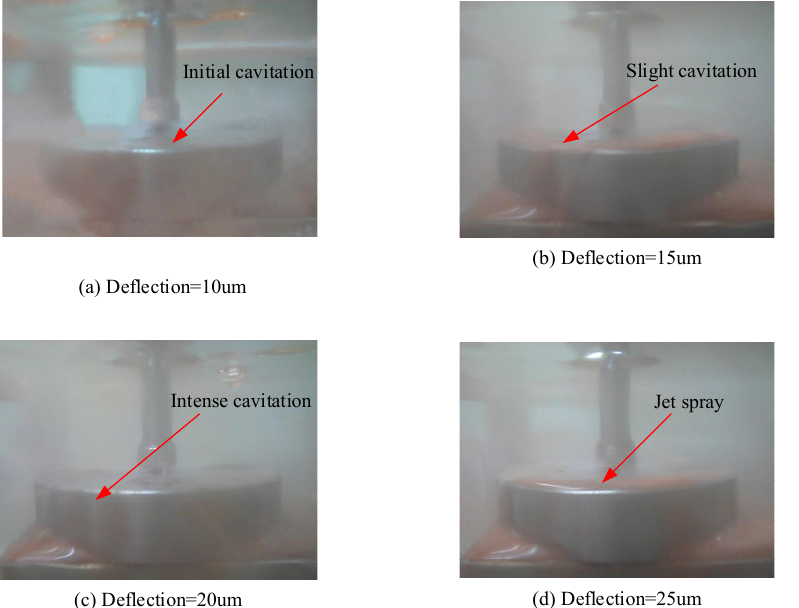
Figure 24. Cavitation phenomena with different deflection. ( a ) Cavitation phenomenon with the deflection of 10 μ m; ( b ) Cavitation phenomenon with the deflection of 15 μ m; ( c ) Cavitation phe- nomenon with the deflection of 20 μ m; ( d ) Cavitation phenomenon with the deflection of 25 μ m.